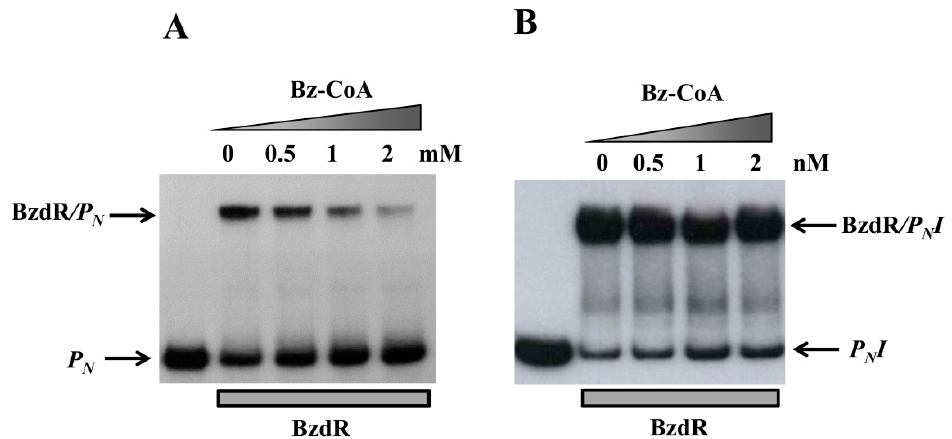
Figure 5. Gel retardation analysis of BzdR binding to the P N ( A ) or the P N I promoter ( B ). Gel retardation analysis was performed as described in Section 2.8 by using 10 nM purified His 6 -BzdR in the presence of increasing concentrations (from 0 to 2 mM) of benzoyl-CoA (Bz-CoA). The free P N probe and the BzdR / P N complex ( A ) or P N I probe and the BzdR / P N I complex ( B ) are indicated by arrows.